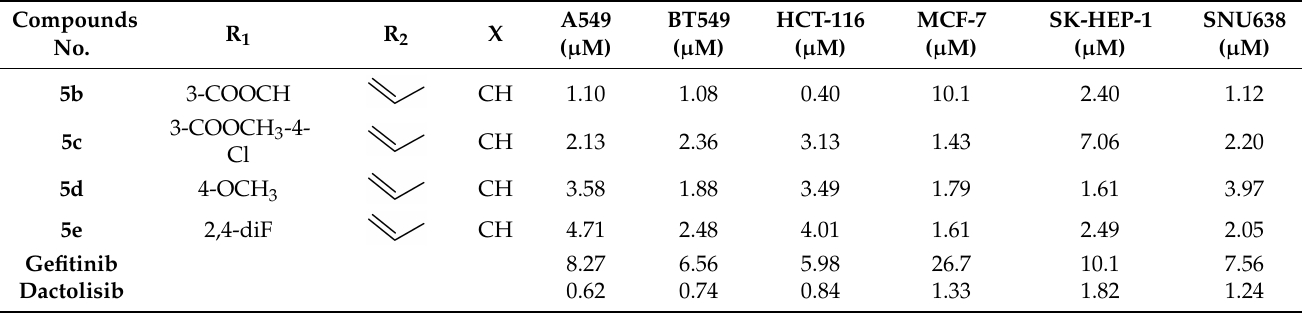
Figure 6. Structure of aminoquinazoline ‐ sulphonamide hybrids and the most promising compound 5a. Table 5. In vitro cytotoxic activities of hybrid compounds 5 ( b – e